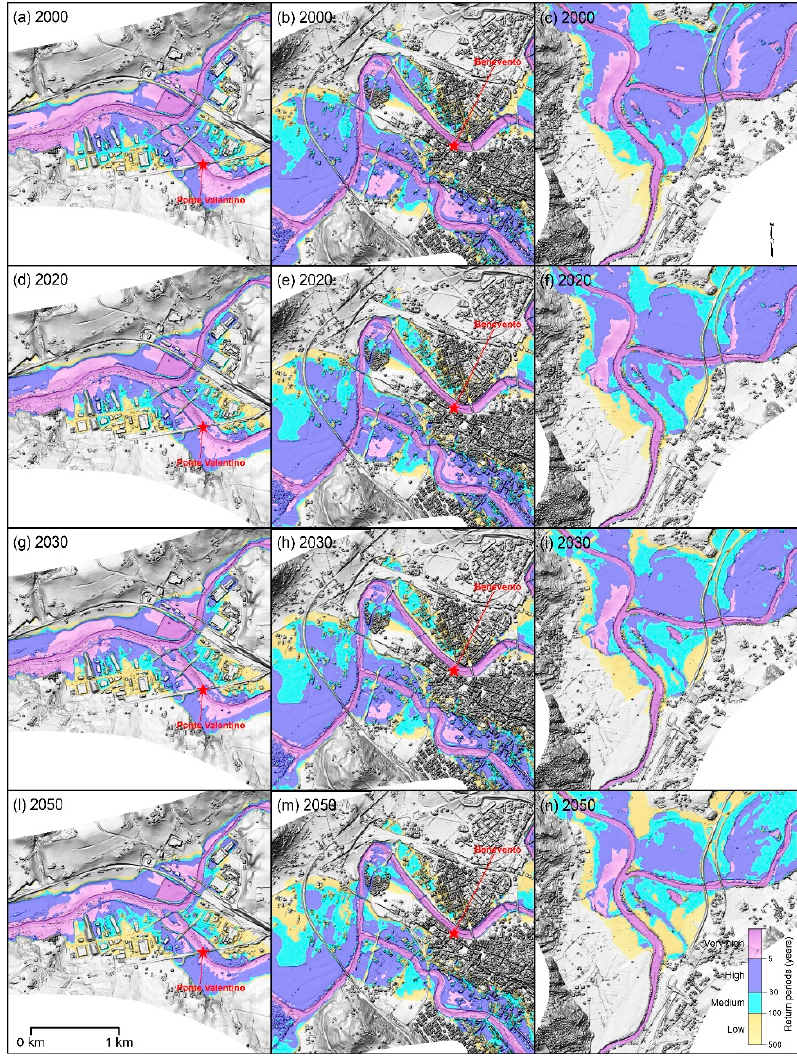
Figure 5. Magnification of zonation in flood perspective scenario at selected relevant regions of the study area (i.e., dark polygons of Figure 1). Figure ( a – c ) show the past flood hazard scenario (i.e., AD 2000) across the area covered by polygons a, b and c, respectively, in Figure 1. Figure ( d – f ) show